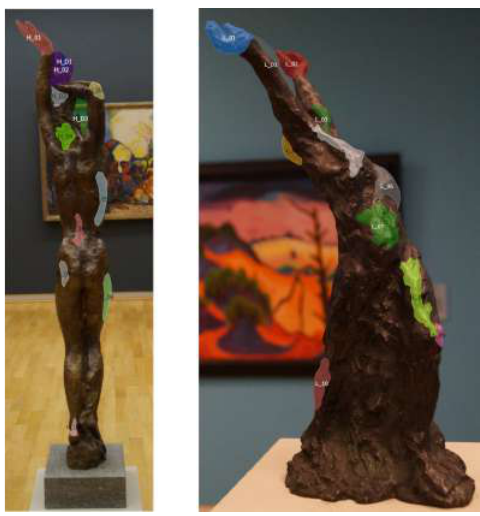
Figure 3. Expert defined AOIs also known as basic features on Daphne (on the left, Sintenis, 1930/1991) and Moses (on the right, Kroner, 1919) exemplary on one reference